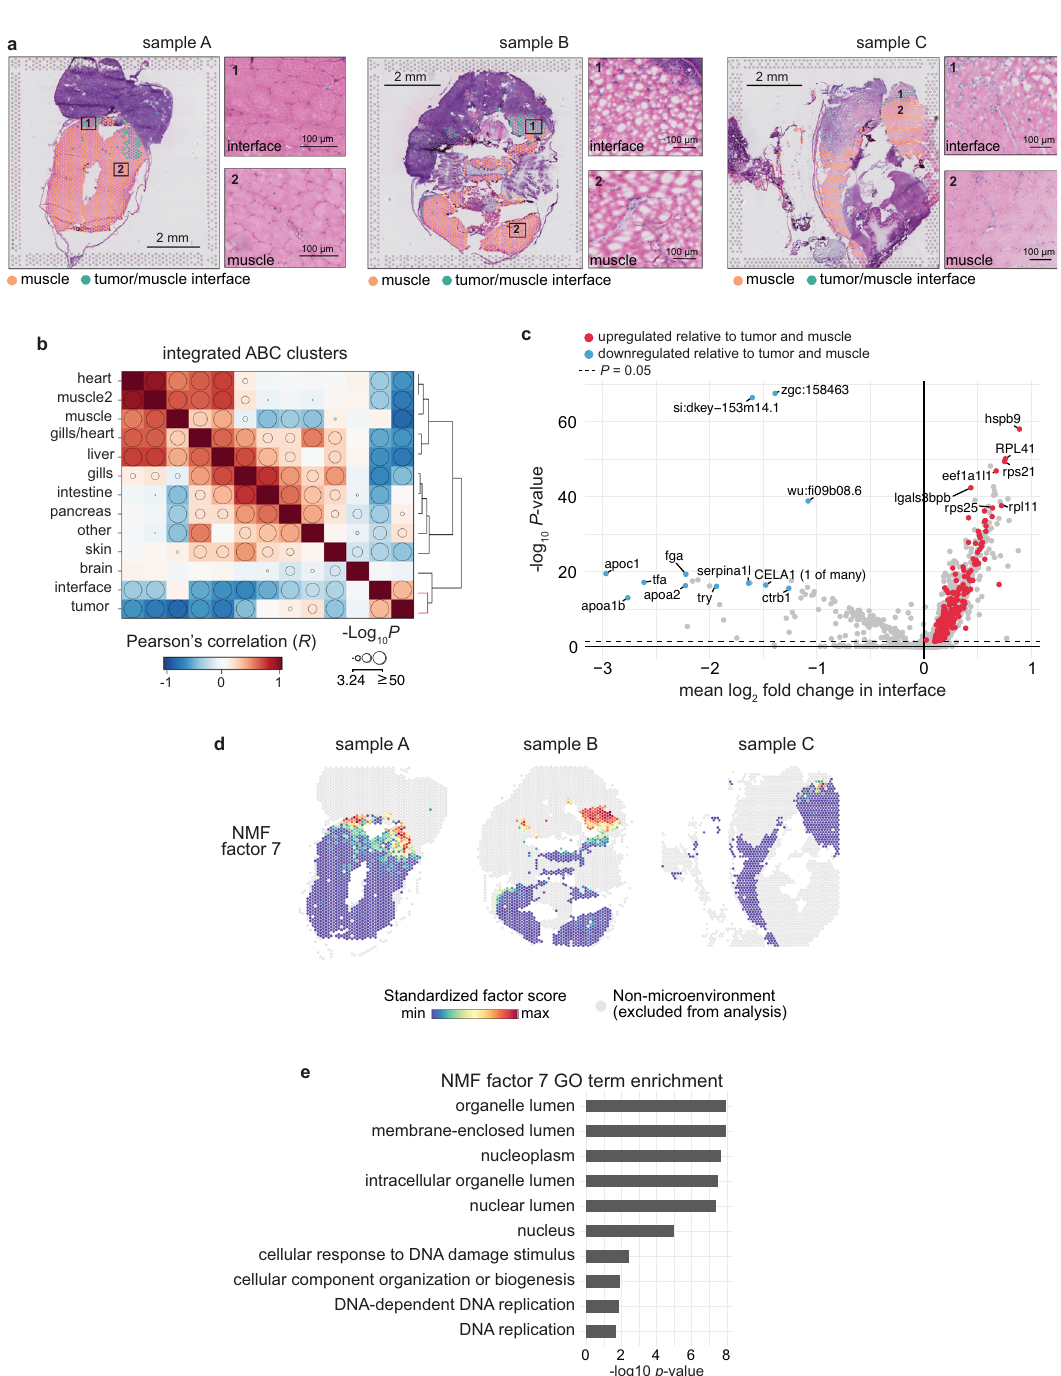
Fig. 2 The tumor – microenvironment interface is transcriptionally distinct from the surrounding microenvironment. a Interface and muscle-annotated cluster spots projected onto tissue image ( n = 3 sections). Insets show the tissue underlying the interface spots (1) and muscle spots (2). b Correlation matrix between average expression pro fi le of SRT clusters across all three datasets. Clusters are ordered by hierarchical clustering of the Pearson ’ s correlation coef fi cients (see “ Methods ” section) and bubble sizes correspond to p -value ( − log10) of correlation (two-sided), with p -values < 10 − 3 omitted. Clustering of tumor and interface together is highlighted in the dendrogram (red). c Volcano plot of differentially expressed genes between the interface cluster versus the muscle and tumor clusters. p -values were obtained from the Wilcoxon ’ s rank sum test (two-sided). d Non-negative matrix factorization (NMF) of the microenvironment spots (muscle and interface clusters). Shown are the standardized factor scores for interface-speci fi c NMF factor 7, projected onto microenvironment spots. Arrows denote areas with higher factor scores. e Enriched GO terms for the top 150 scoring genes in NMF factor